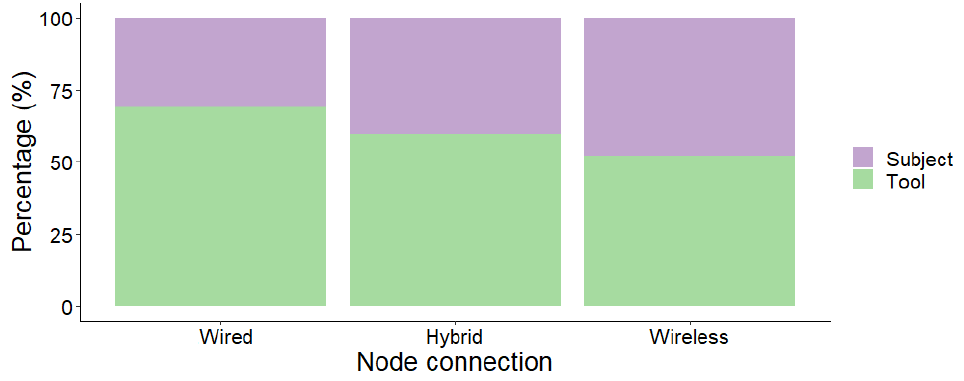
Figure 37. Deployment distribution between node connection type and deployment type.